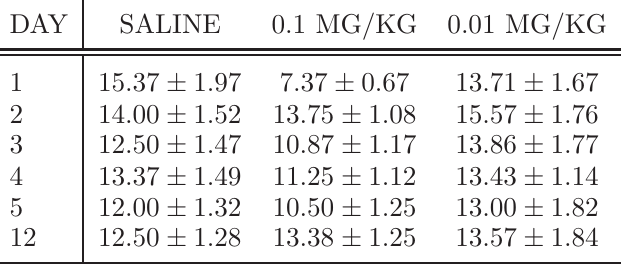
Table 3 Effects of CGP76291 on active avoidance